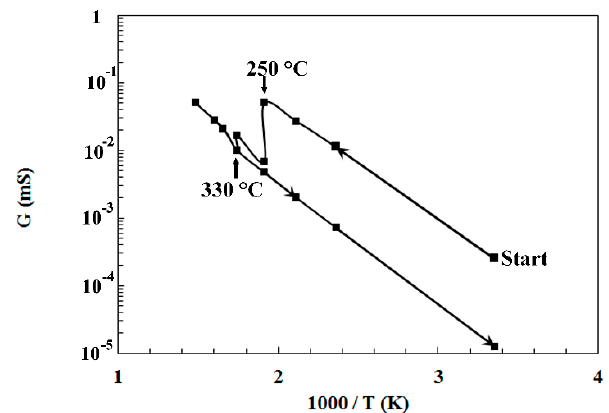
Figure 6. Evolution of the conductance of the sensor-400 in air versus reciprocal temperature.